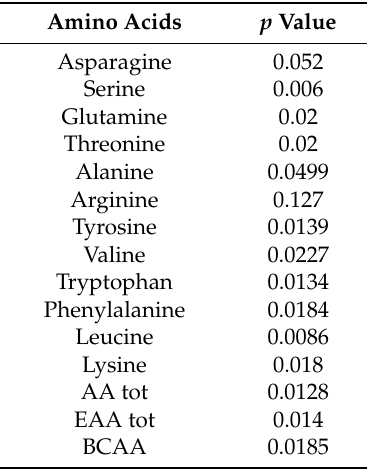
Table 4. Significant correlations between arterial amino acids × CI ( µ mol min − 1 m − 2 ) and left Ventricular Ejection Fraction (%). Amino Acids p